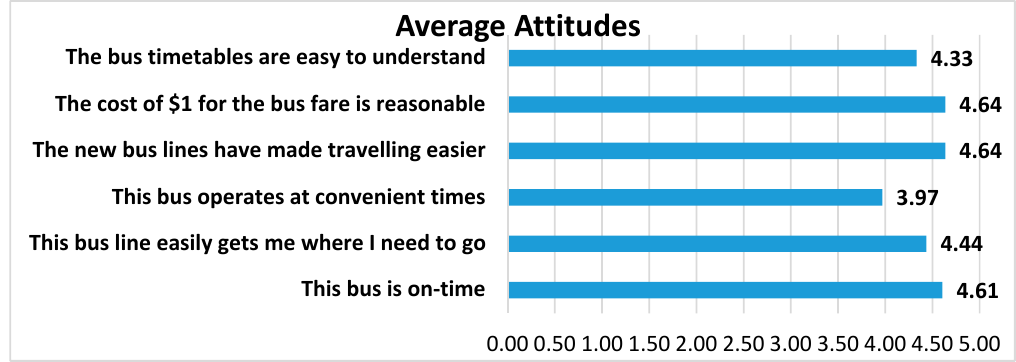
Figure 5. Reasons for taking the bus.